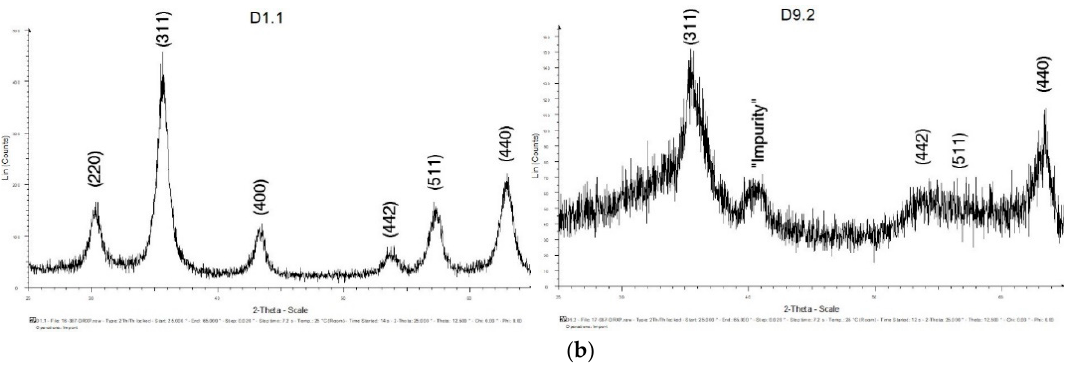
Figure 2. X-ray diffraction (XRD) diffractograms for the different particles produced ( a ) and typical peaks of magnetite assigned, as well as the peak corresponding to the “impurity” that appears in samples 9–12 ( b ). Table 2. Crystallite sizes estimated by the Scherrer formula and corresponding magnetic susceptibility values per each experiment. Experiment nr.